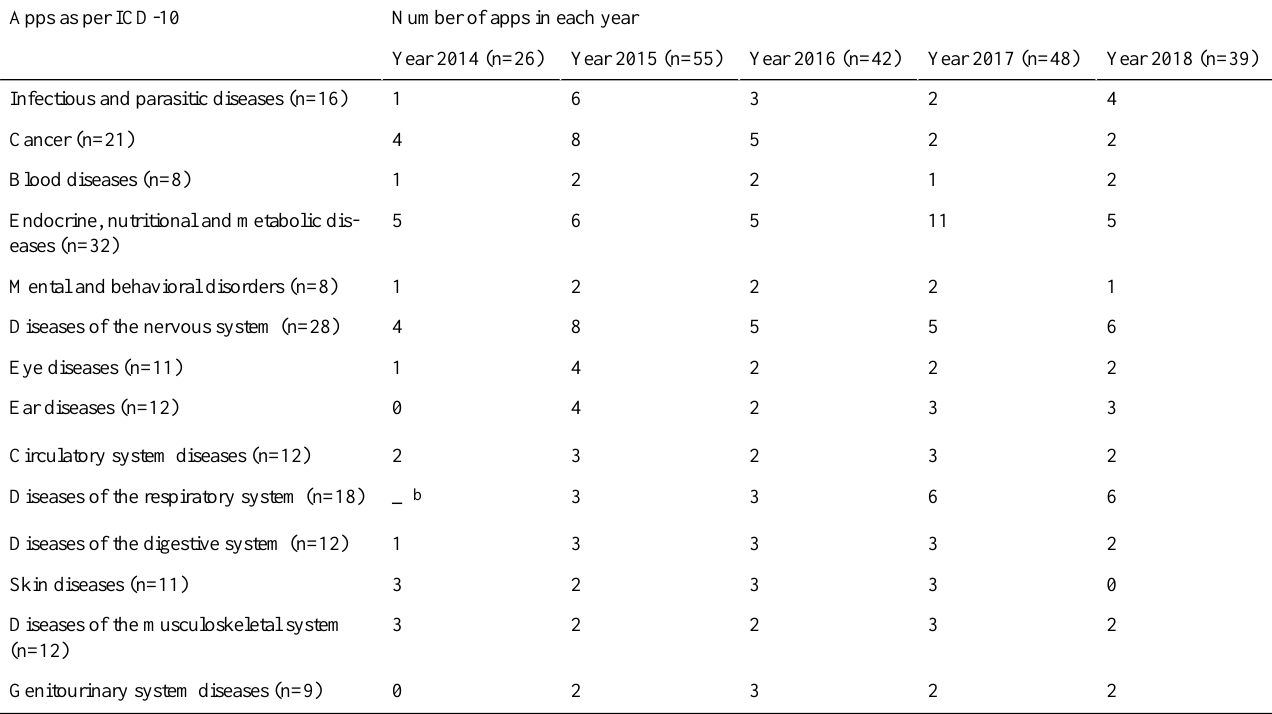
Table 2. Evolution of the health apps included each year, classified by 14 ICD-10 a disease groups (n=210).